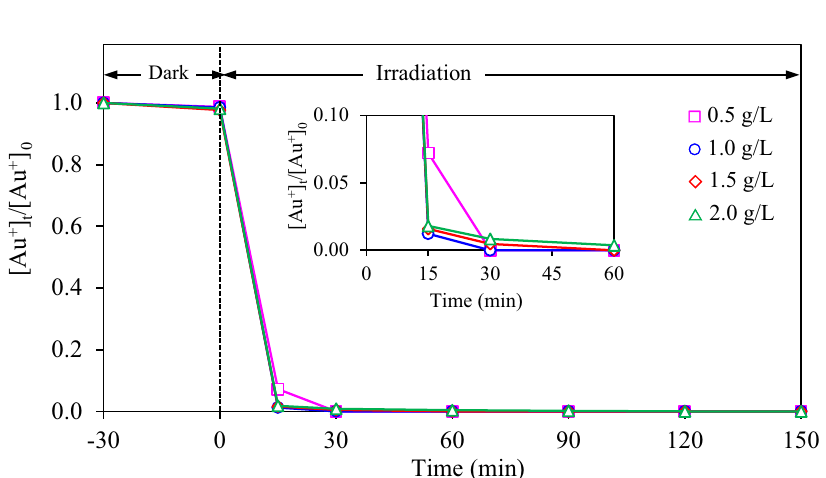
Figure 13. Variation of gold recovery via Au 0.5 /TiO 2 photocatalyst at different dosages and light intensity of 3.20 mW/cm 2 in the presence of 20 vol% CH 3 OH as the hole scavenger.